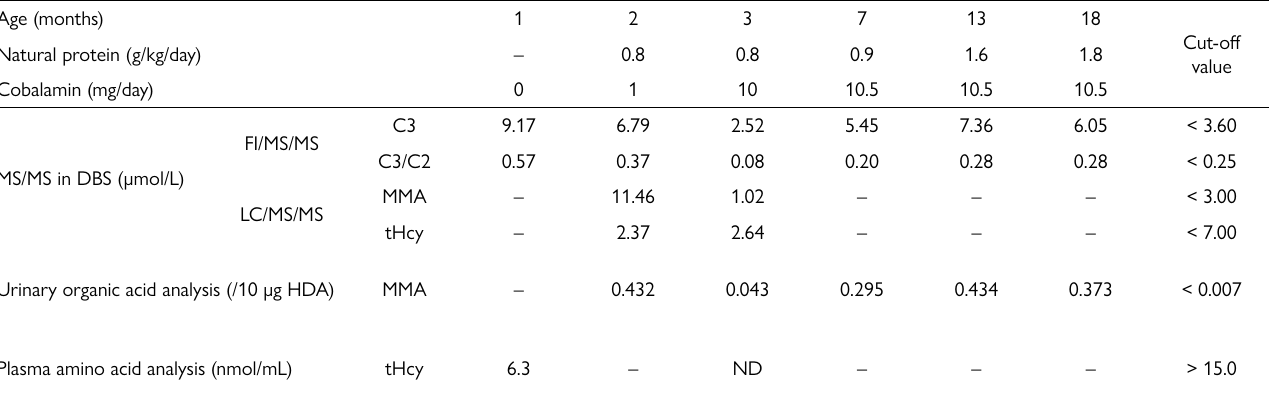
Table 1. Laboratory data for the case before and after cobalamin increase Age (months) Cobalamin